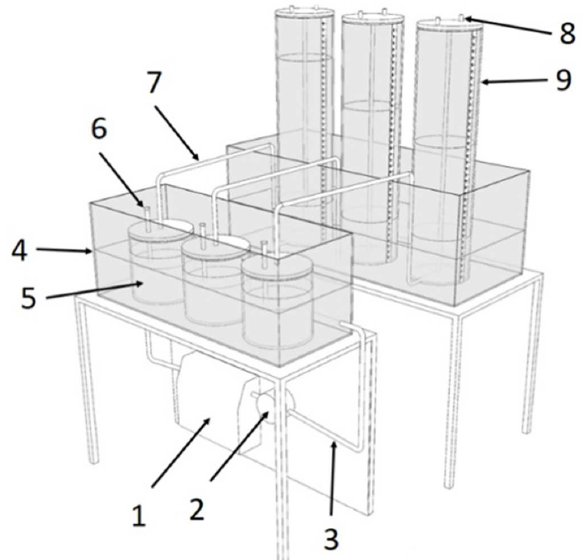
Figure 3. A design of a biofermentor for biogas production research (3-chamber section) [26]: 1— water heater with temperature regulator, 2—water pump, 3—insulated conductors of calefaction liquid, 4—water coat, 5—biofermentor with the charge capacity of 2 dm 3 , 6—sampling tubes, 7— biogas transporting tube, 8—gas sampling valve, 9—biogas volume-scale reservoir.